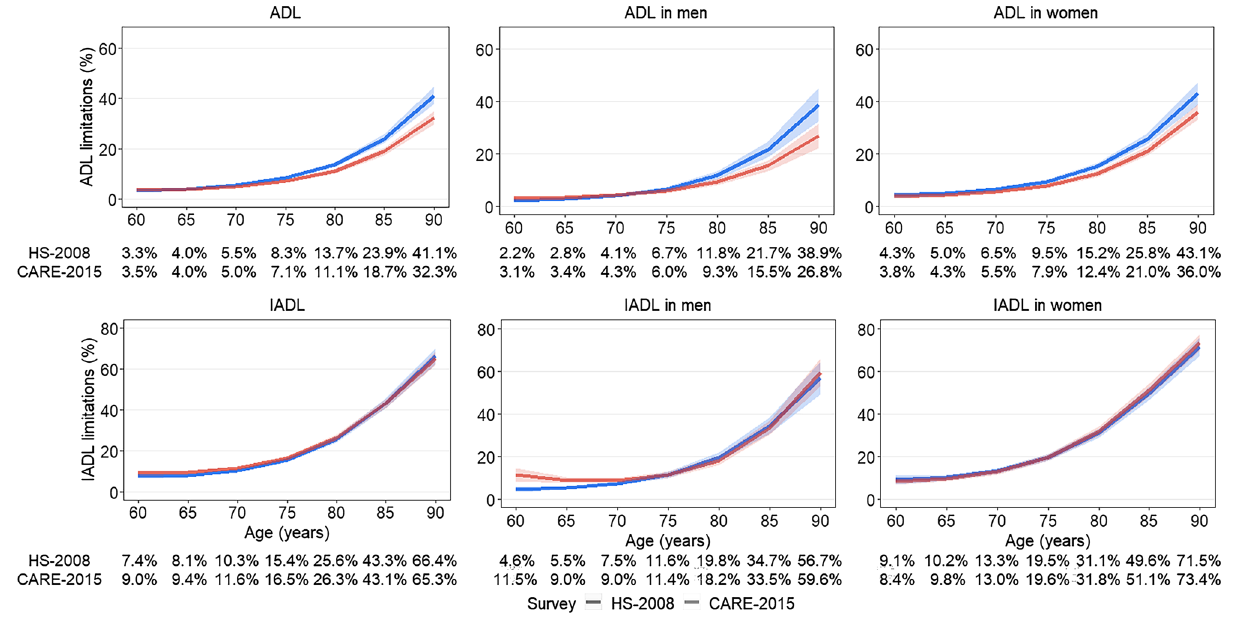
Figure 1. Prevalence of ADL and IADL limitations in HS-2008 and CARE-2015 surveys a and by sex b . HS: Handicap Santé; CARE: Capacities, Aids and REssources; ADL: Activities of Daily Living; IADL: Instrumental Activities of Daily Living. a Estimated using weighted logistic models adjusted for survey (HS-2008, CARE-2015), age, age 2 , survey x age, sex, multimorbidity, education, and for significant interactions between covariates and age terms. b Estimated using weighted logistic models stratified on sex and adjusted for survey (HS-2008, CARE- 2015), age, age 2 , survey x age, multimorbidity, education and for significant interactions between covariates and age